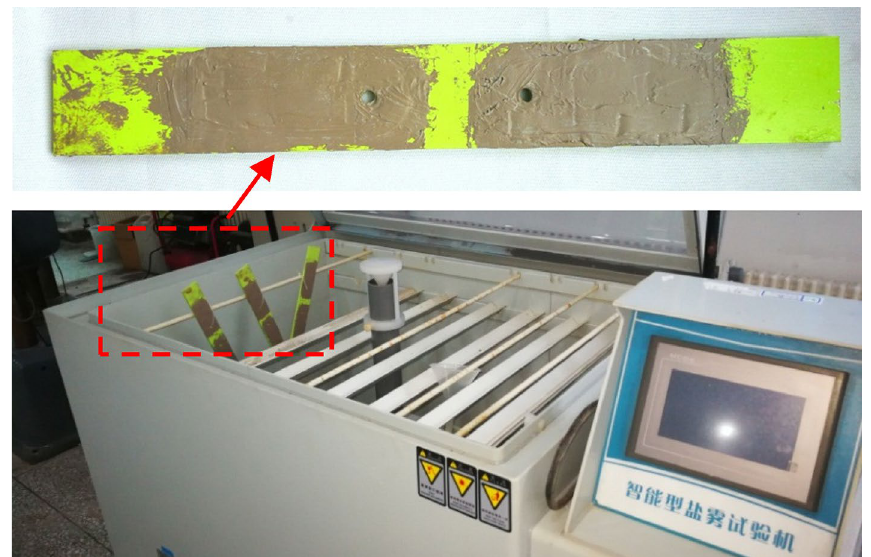
Figure 13. Salt fog corrosion experiment.